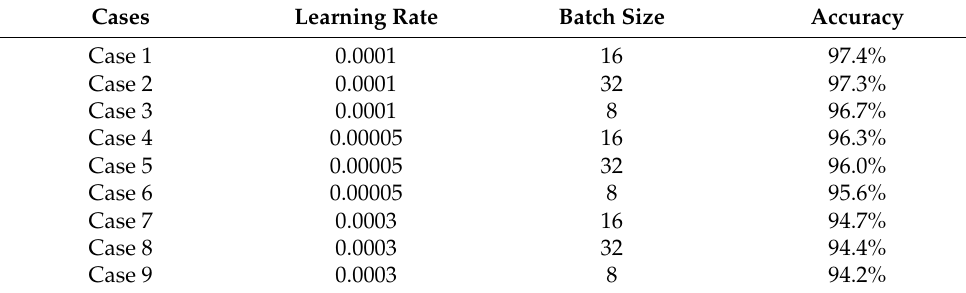
Table 7. Comparison of different hyperparameter combinations.